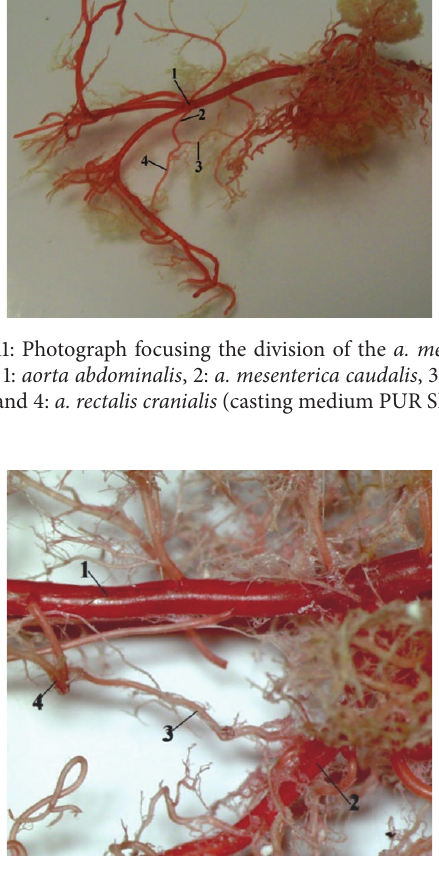
Figure 12: The presence of the anastomosis between a. colica sinistra and a. colica media . 1: aorta abdominalis , 2: a. mesenterica cranialis , 3: a. colica media , and 4: a. colica sinistra (casting medium Duracryl